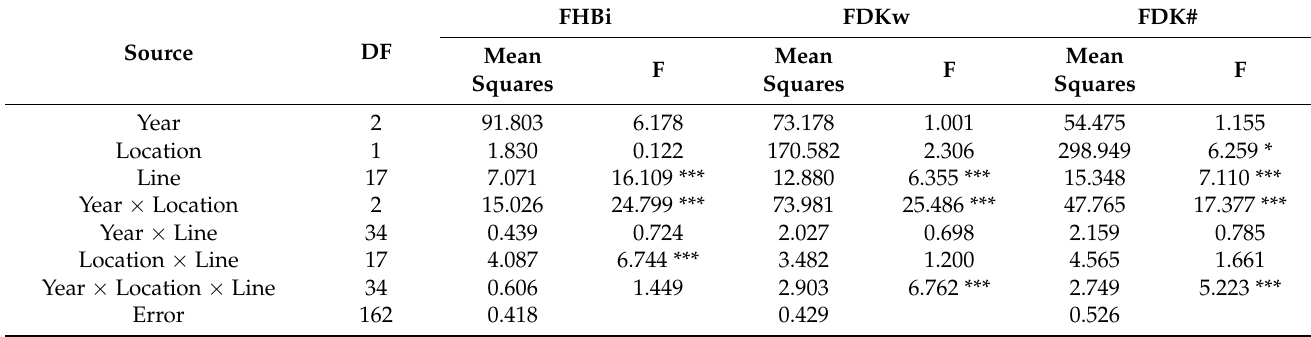
Table 5. Analysis of variance of Fusarium head blight index (FBI) and Fusarium -damaged kernels percentage (weight, number).